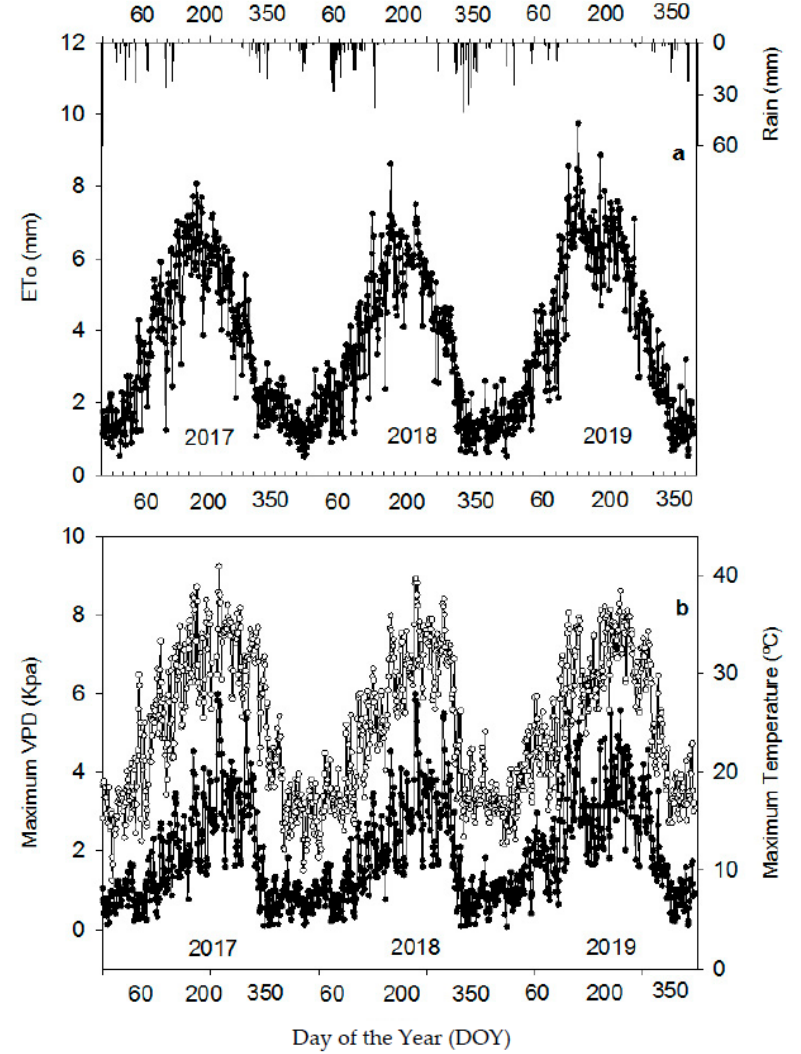
Figure 1. Climatic conditions during the three experimental seasons (2017–2019). ( a ) Seasonal daily reference evapotranspiration (circles) and rain (bars). ( b ) Seasonal daily maximum air temperature (white circles) and maximum vapor pressure deficit (VPD) (black circles). Vertical dots lines indicated from right to left each season, the beginning of pit hardening, early recovery, and regular recovery. DOY: day of the year.